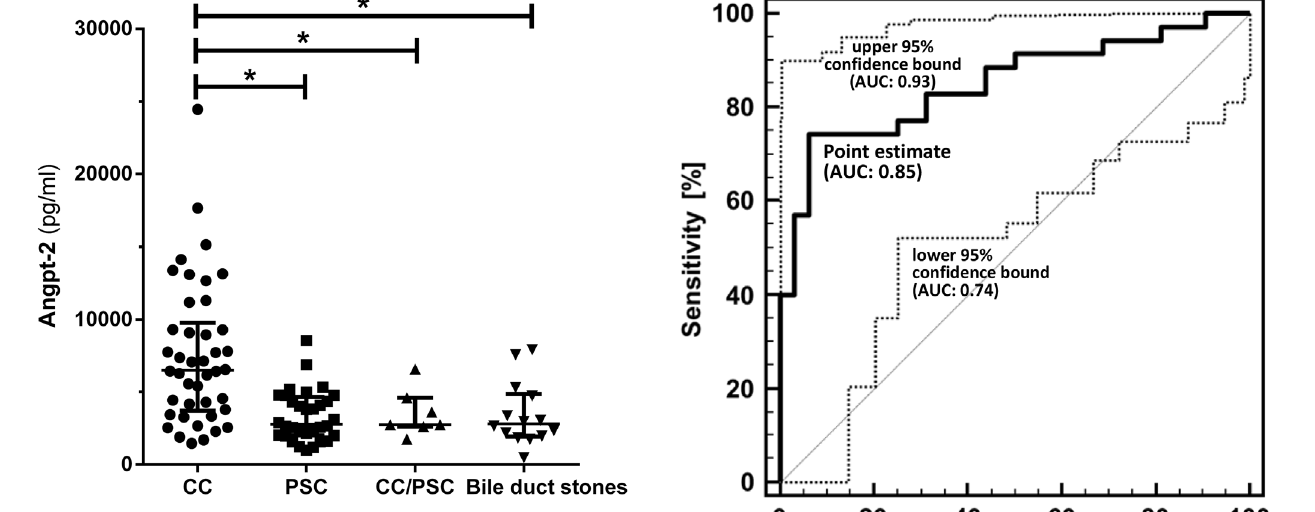
Figure 1. Serum Angpt-2 is elevated in patients with CC, (A). Angpt-2 was measured in patients with CC (n=42), PSC (n=34), CC/PSC (n=7) and patients with bile duct stones (n=14). Serum Angpt-2 was significantly elevated in patients with CC compared to control patients (p , 0.01). Angpt-2 in bile is not associated with CC, (B). Bile concentration of Angpt-2 was measured in patients with CC (n=20), PSC (n=68), CC/PSC (n=8) and patients with bile duct stones (n=34). Four values (CC) are outside the scale of the Y-axis. No significant differences were detected among the groups.